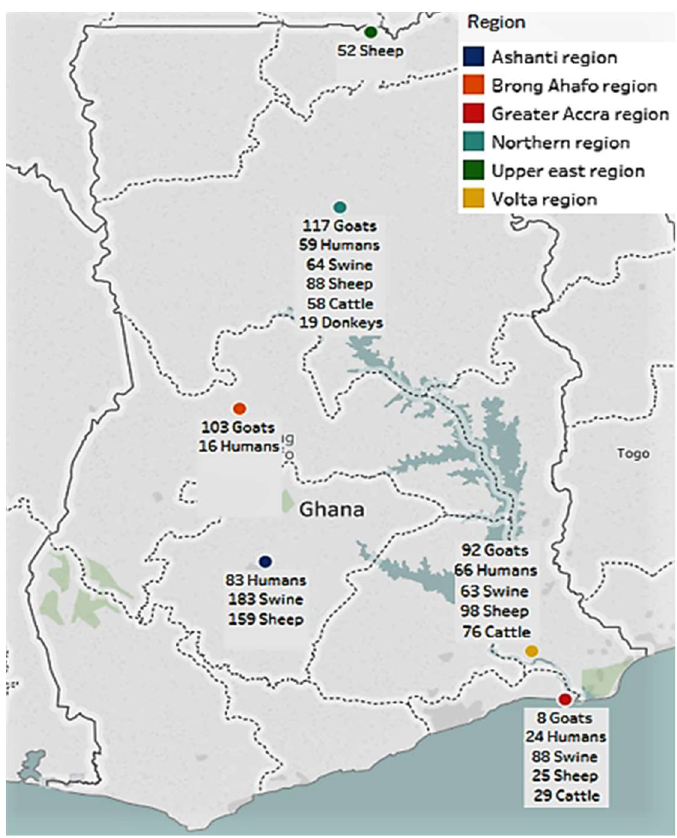
Figure 1. Distribution of human and livestock samples collected in the study.